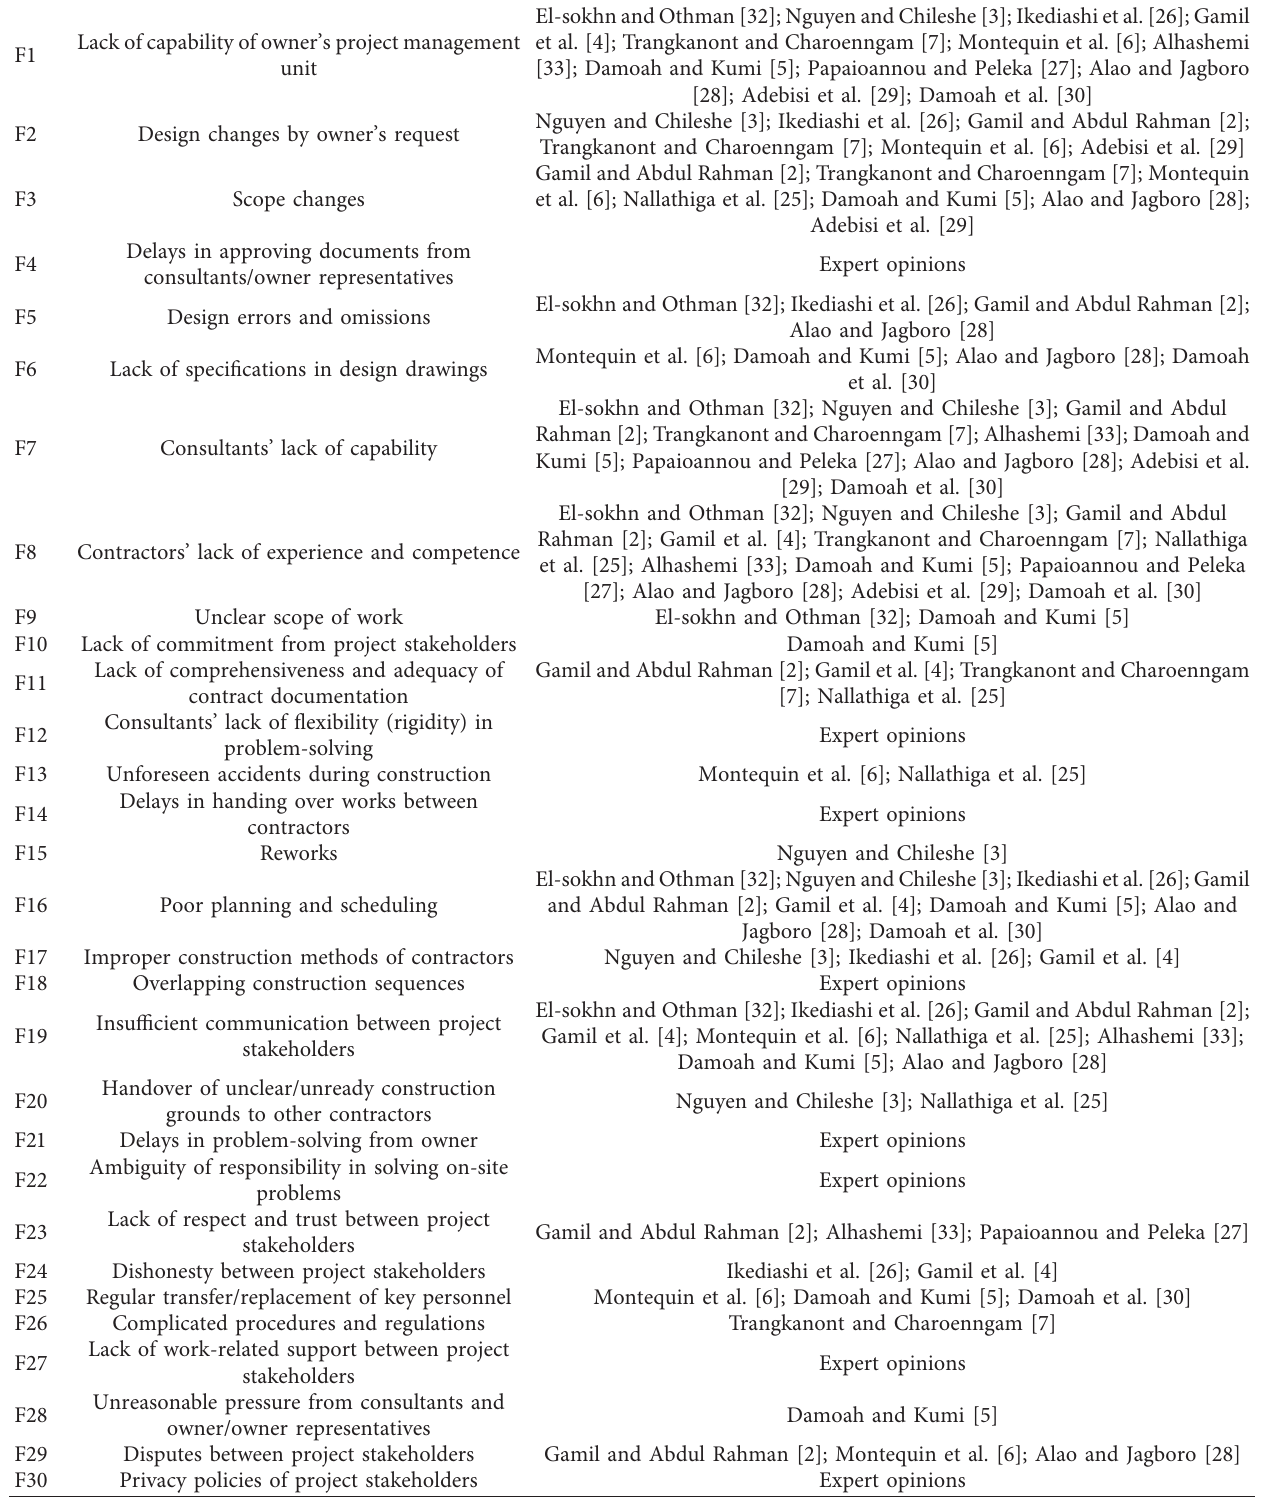
Table 1: List of potential construction failure factors to stakeholder coordinating